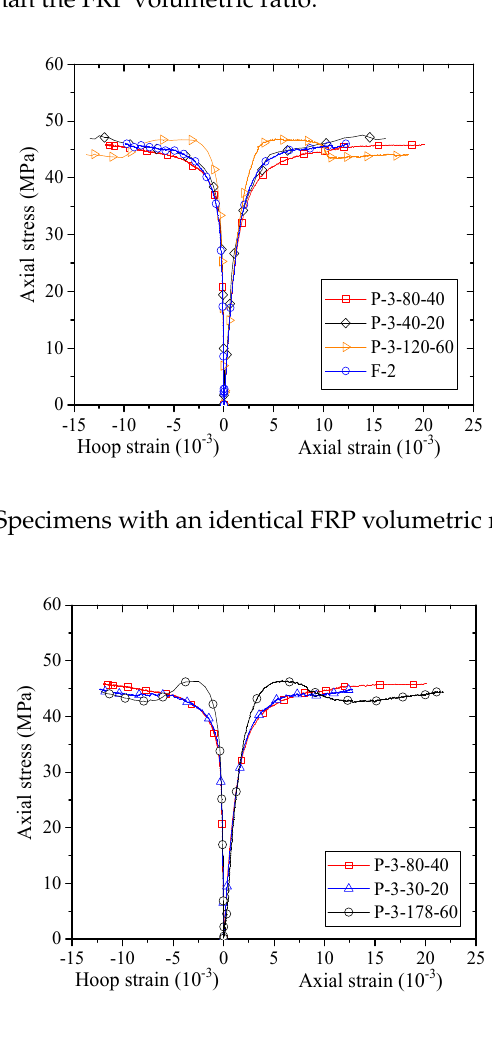
Figure 12. Stress–strain curves of concrete in the specimens with an identical FRP volumetric ratio and an identical confinement efficiency ratio.